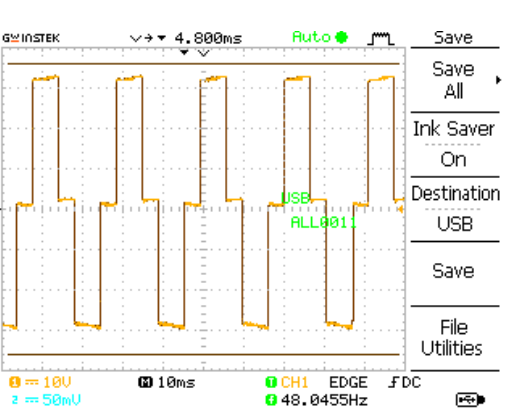
Figure 22. Experimental modified AC voltage.